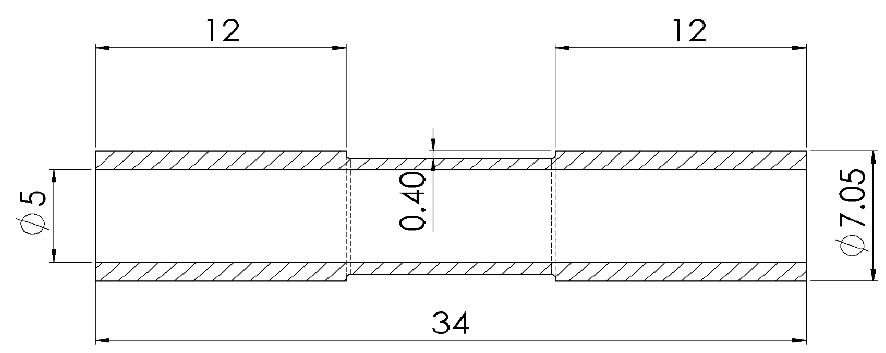
Figure 1. Schematic of the specimen used to determined the oxidation kinetics, in mm.